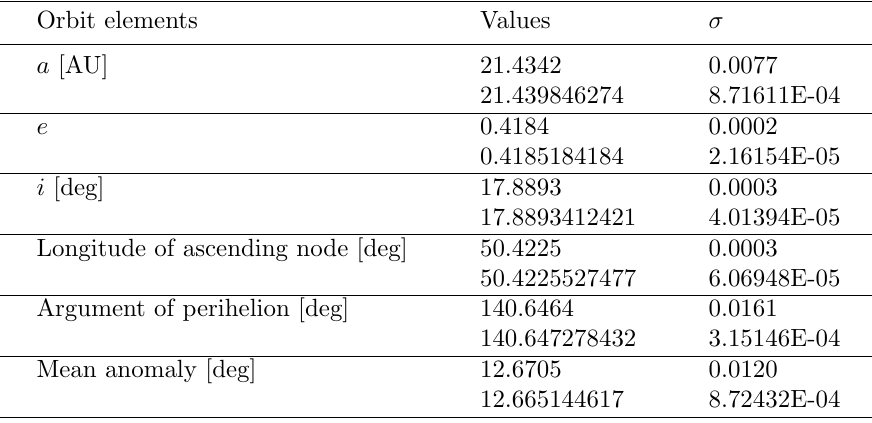
Table 5. Orbital elements and their 1 σ errors (rms) for 2009 HW77, calculated with the OrbFit software. Epoch: JD 2455400.5 TDT = 2010-07-23, rms = 0.416 (cid:48)(cid:48) both in our previous (top lines) and present (bottom lines)